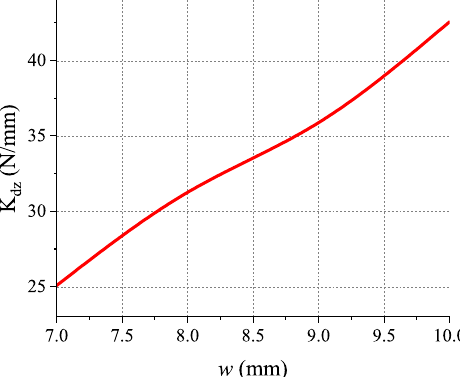
Figure 8. Stiffness under different geometrical parameters.